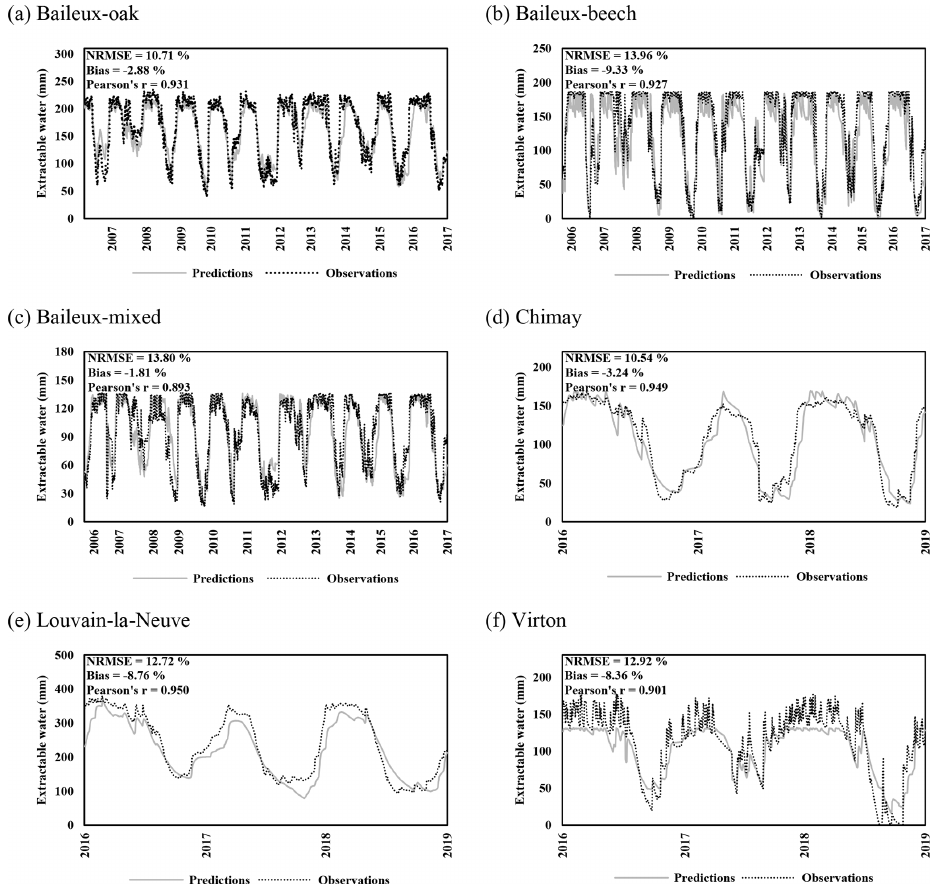
Figure 7. Temporal dynamics of observed and predicted extractable water amount (in millimetres) in the various stands. The prediction quality is indicated by the NRMSE, the relative bias and the Pearson’s correlation coefficient ( r